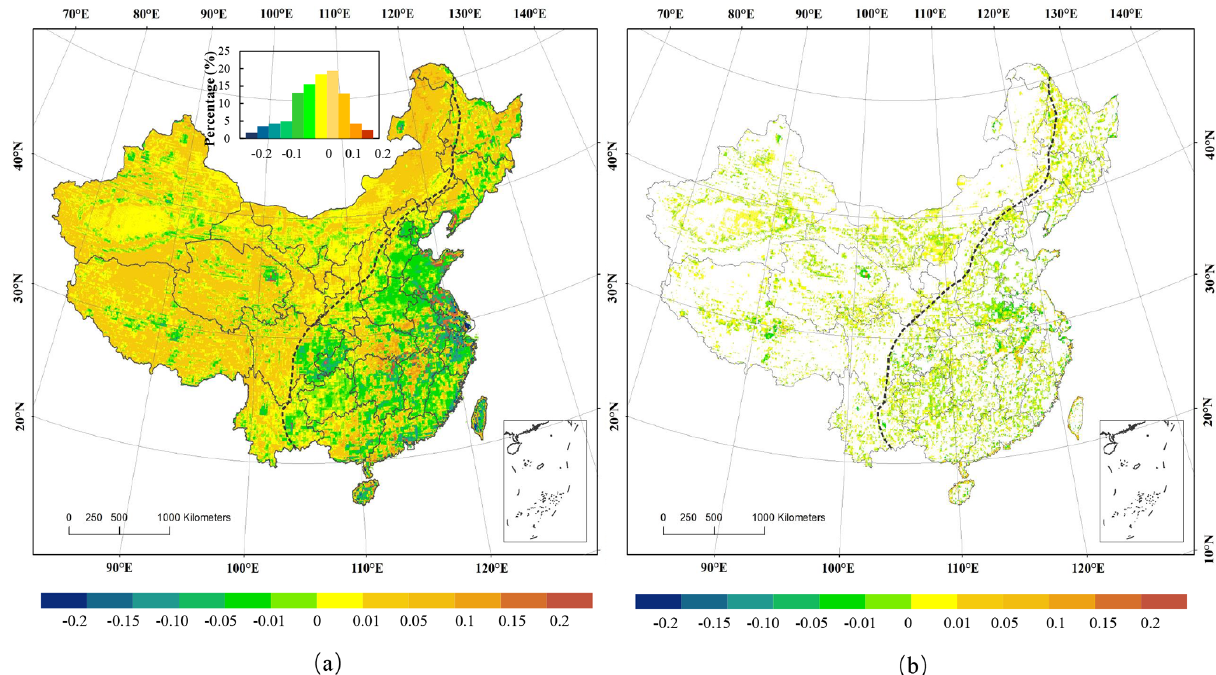
Figure 7. Spatial distribution of annual SM variability in slope based on downscaled data from 2002 to 2018. (a) Slope trend values of all pixels and (b) propensity slope trend values is at 90% confidence level. The dotted black line is the dividing line between wet and dry